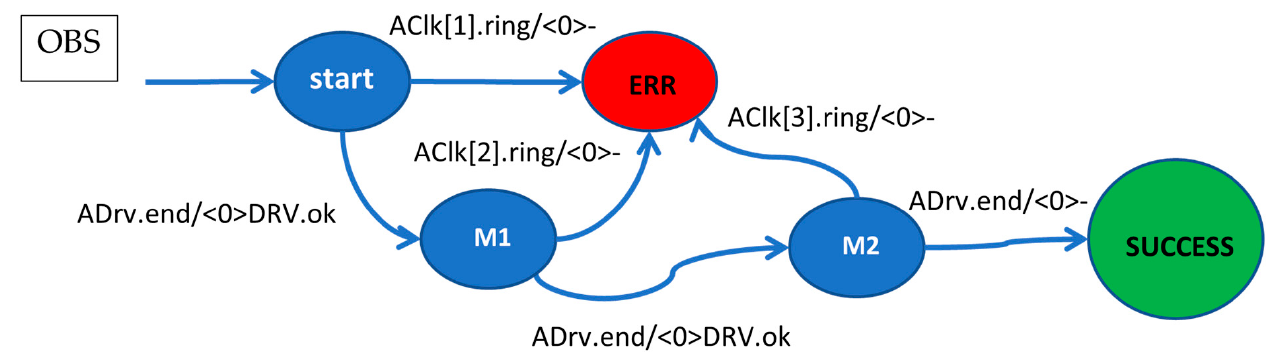
Figure 13. The observer automaton OBS.